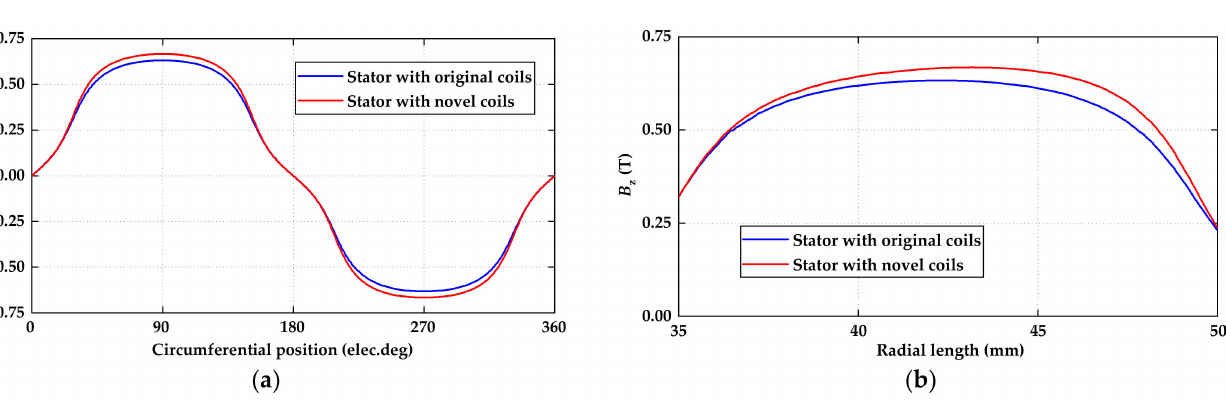
Figure 6. Axial component of the air gap flux density: ( a ) at different circumferential positions; ( b ) at different radial